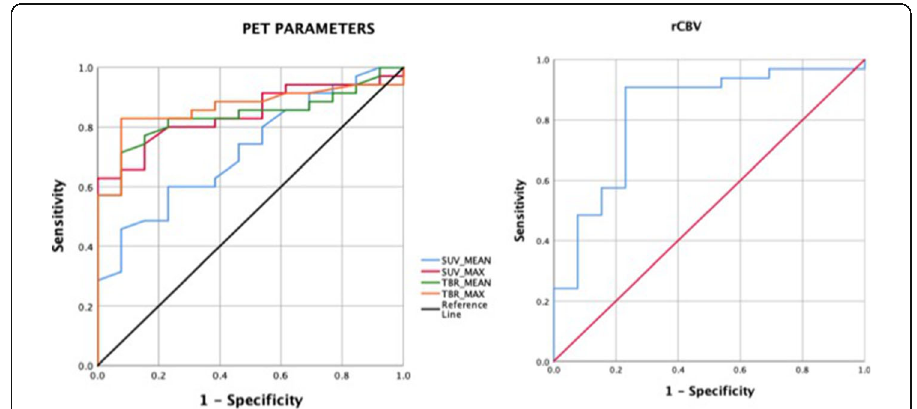
Fig. 2 ROC curve analysis for PET parameters on the left and relative CBV on the right. The highest area under curve was obtained for TBR max among the PET parameters followed by SUV max , TBR mean , and SUV mean in that order